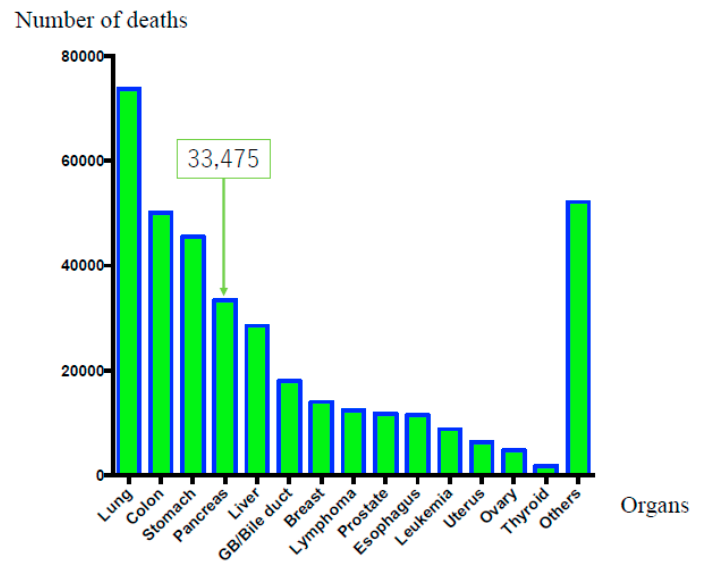
Figure 2. Mortality rate in according to the affected organ (in Japan). The overall numbers of cancer-related deaths in 2016 were as follows: (1) lung cancer, 73,838 cases; (2) colorectal cancer, 50,099 cases; (3) gastric cancer, 45,531 cases; and (4) pancreatic carcinoma, 33,475 cases (men: 17,060 cases, women: 16,415 cases).